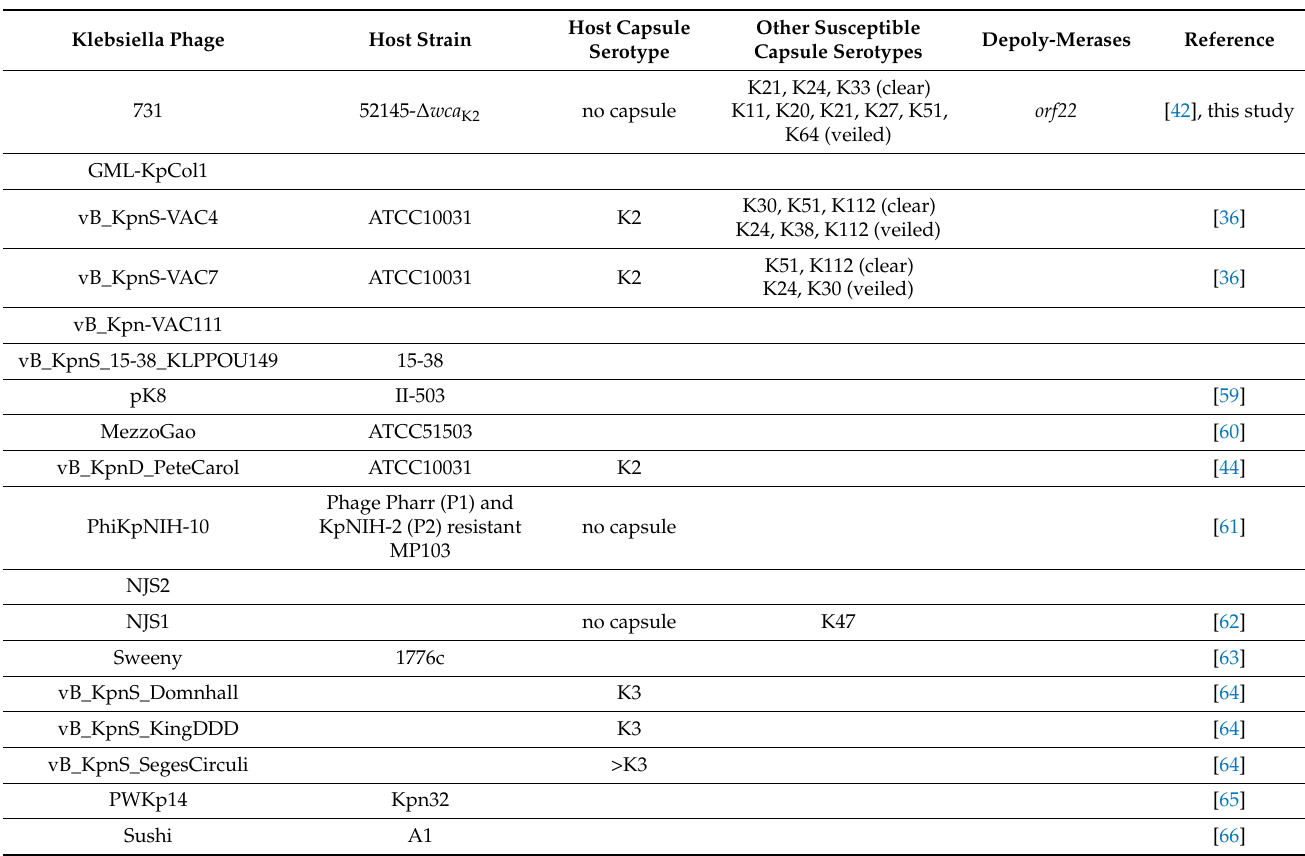
Table 2. Comparison of Klebsiella phages from Webervirus genus, homologous to 731. Host and capsule specificity available in the literature is indicated. The phage genome similarities are presented in Figure 6, putative depolymerase homologies (for orf22 ) are in Figure 5. Order of the phages follows the multiple alignment by COBALT (Figure 5). Blank cells mean that the corresponding data is yet unknown. Accession numbers of the phages are listed in Supplementary Table